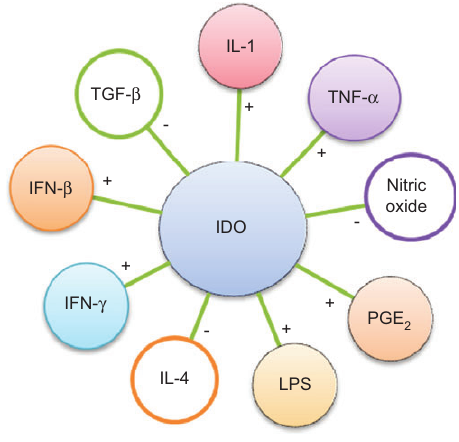
Figure 1 Effect of cytokines or other immune regulatory factors on